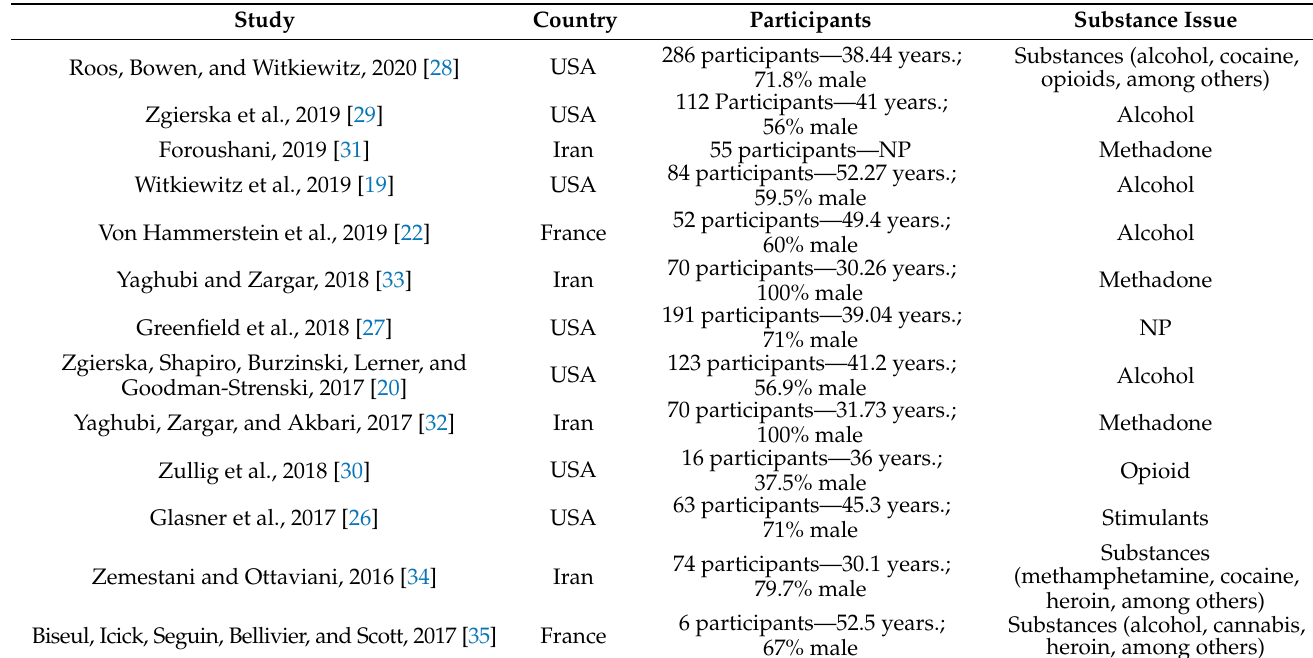
Table A2. Characteristics of the included studies.